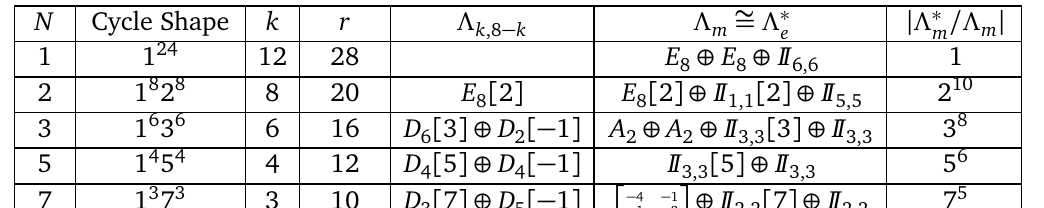
Table 1: A class of Z inverse counts 1 / 2 BPS states, r = 2 k + 4 is the rank of the gauge group and Λ of magnetic charges in four dimensions. The discriminant group Λ ∗ Agreement between the lattice Λ isomorphisms